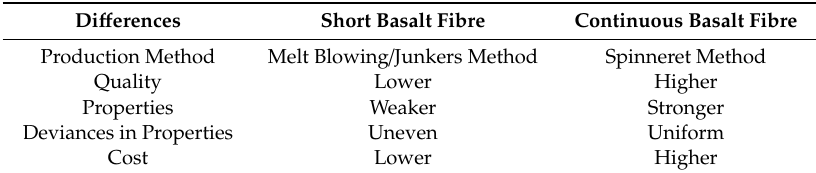
Table 3. Di ff erence between short and continuous basalt fibre. (Adapted from Hafsa & Rajesh, 2015 and De á k & Czig á ny, 2009